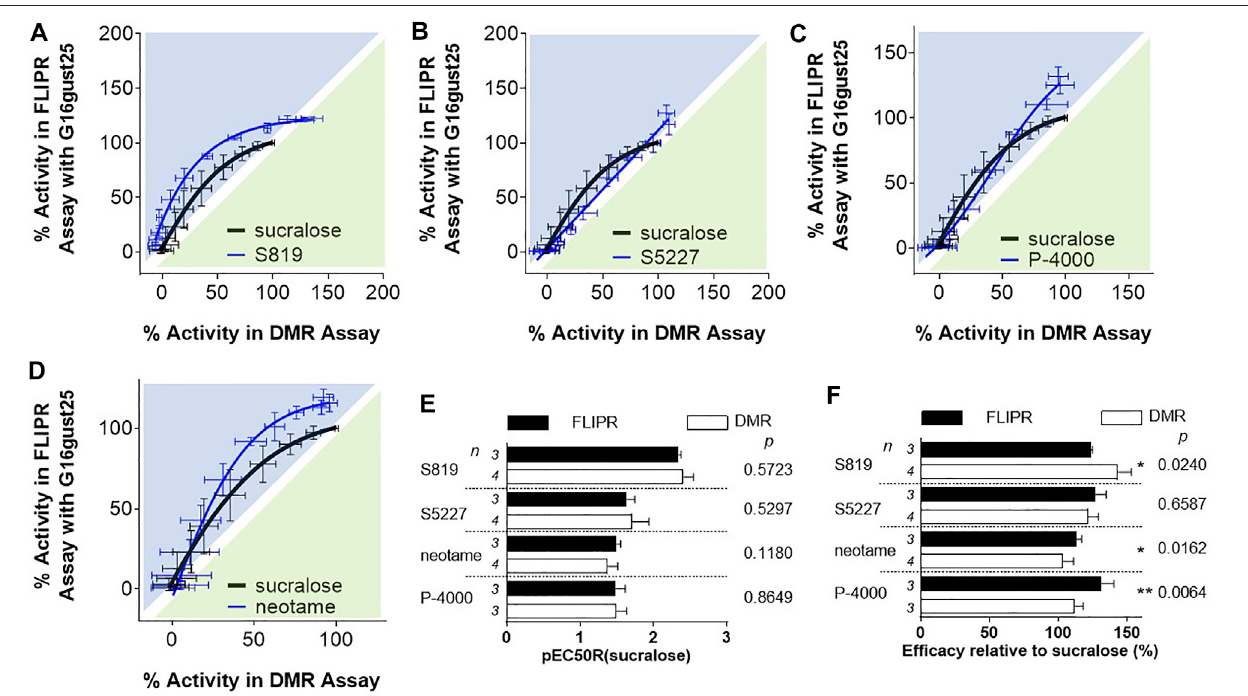
FIGURE 7 | Evaluation of agonists in the FLIPR assay with R2/R3 U2OS cells expressing G α 16gust25 . For Panels (A – D) , bias plotting analysis as described in Figure 5 .Traces arerepresentative ofthree independent experiments and datapoints correspondtoan averageand standarddeviationoftriplicate determinations. (E) Potency bias analysis was performed as described in Figure 6 . (F) Ef fi cacy bias analysis was performed as described in Figure 6 .